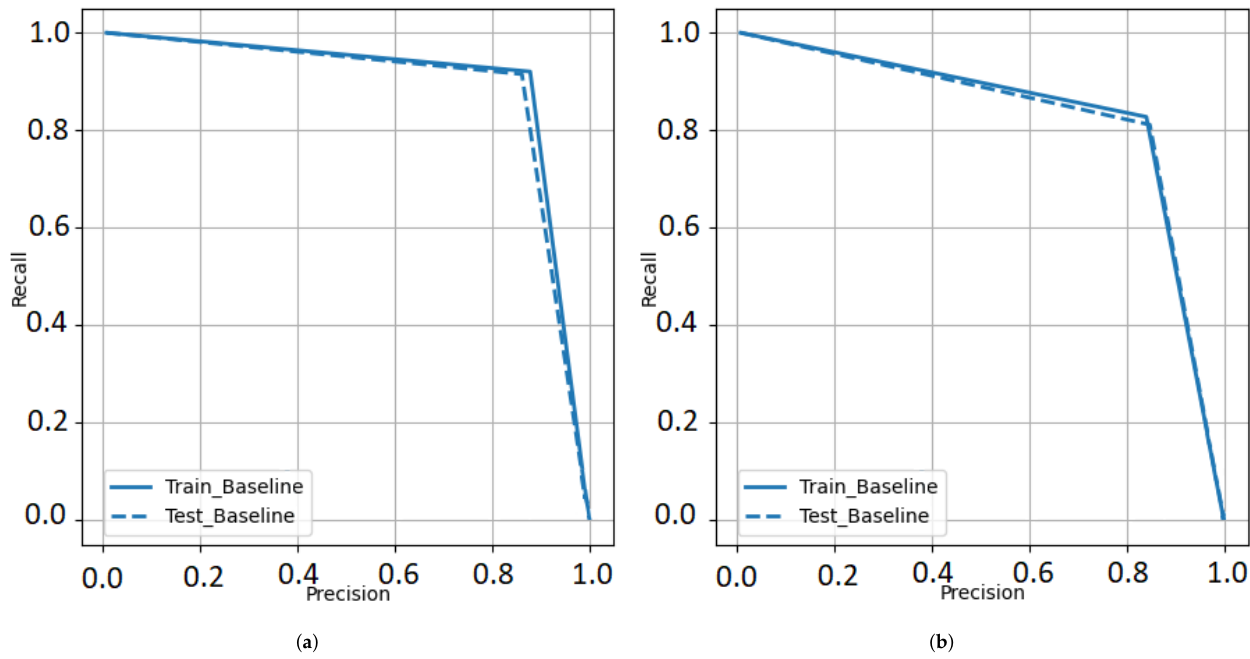
Figure 9. Precision-Recall curves for UNet segmentation approach using ( a ) UNet Model 1 and ( b ) UNet Model 2.